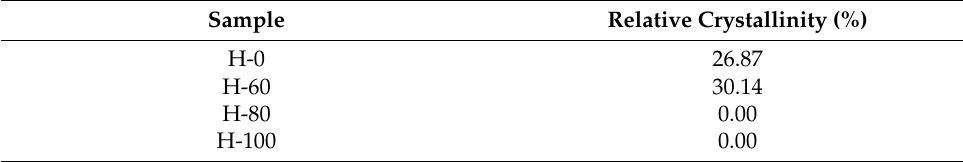
Figure 2. X-ray diffraction pattern of native adlay flour (H-0) and pre-gelatinized adlay flours Table 2. Relative crystallinities of native adlay flour (H-0) and pre-gelatinized adlay flours prepared at different temperatures (60 ◦ C (H-60), 80 ◦ C (H-80), and 100 ◦ C (H-100)).